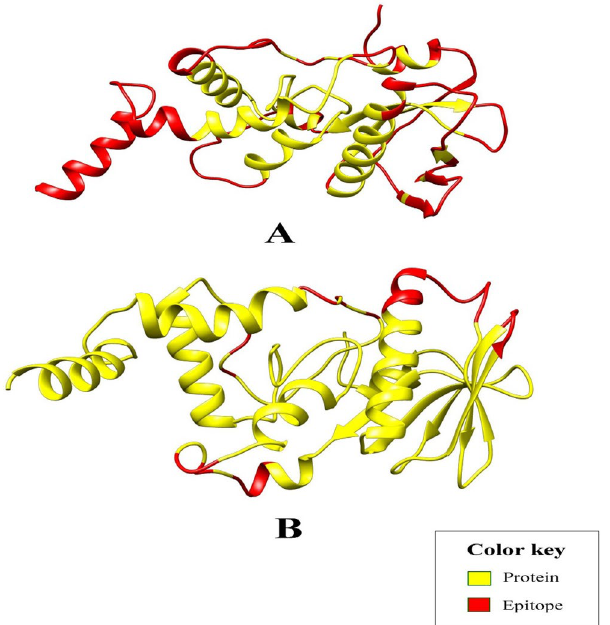
Figure 5. The discontinuous B-cell epitopes (red) within the multi-epitope vaccine as predicted by ( A ) Ellipro tool, and ( B ) DISCOTOPE